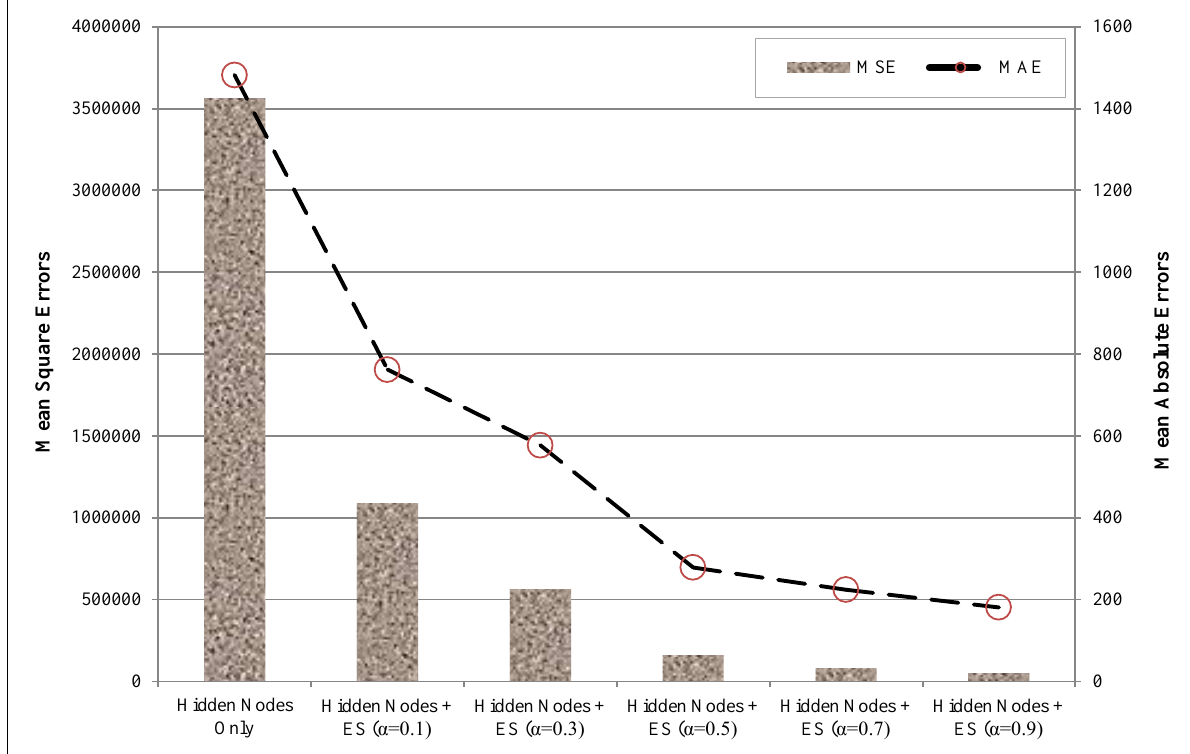
Figure 4. The performance criteria for combined neural network models with exponential